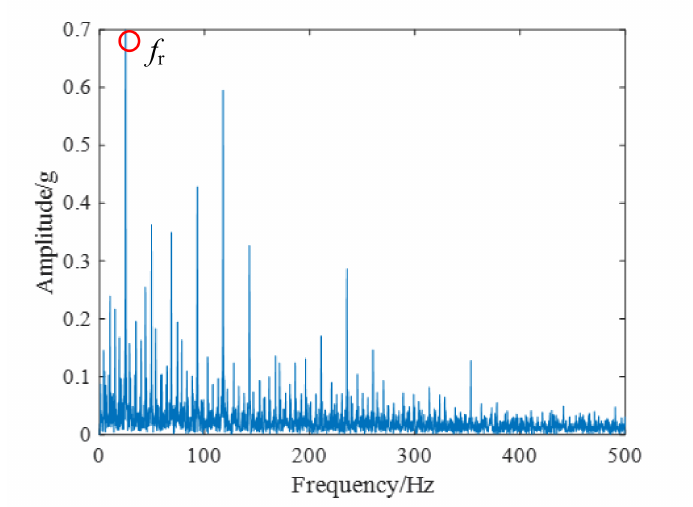
Figure 8. The rolling bearing vibration signal shown in time and frequency domain. ( a ) the time-domain waveform of the bearing signal. ( b ) the frequency-domain waveform of the bearing signal.